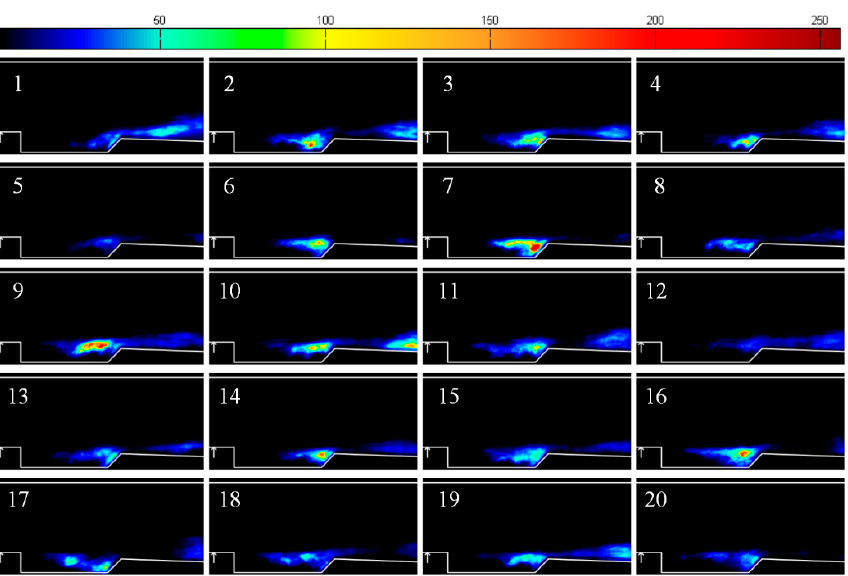
Figure 6. Images of typical transient flames under the mode of combustion oscillation for case 4 ( △ t = 0.2 ms).